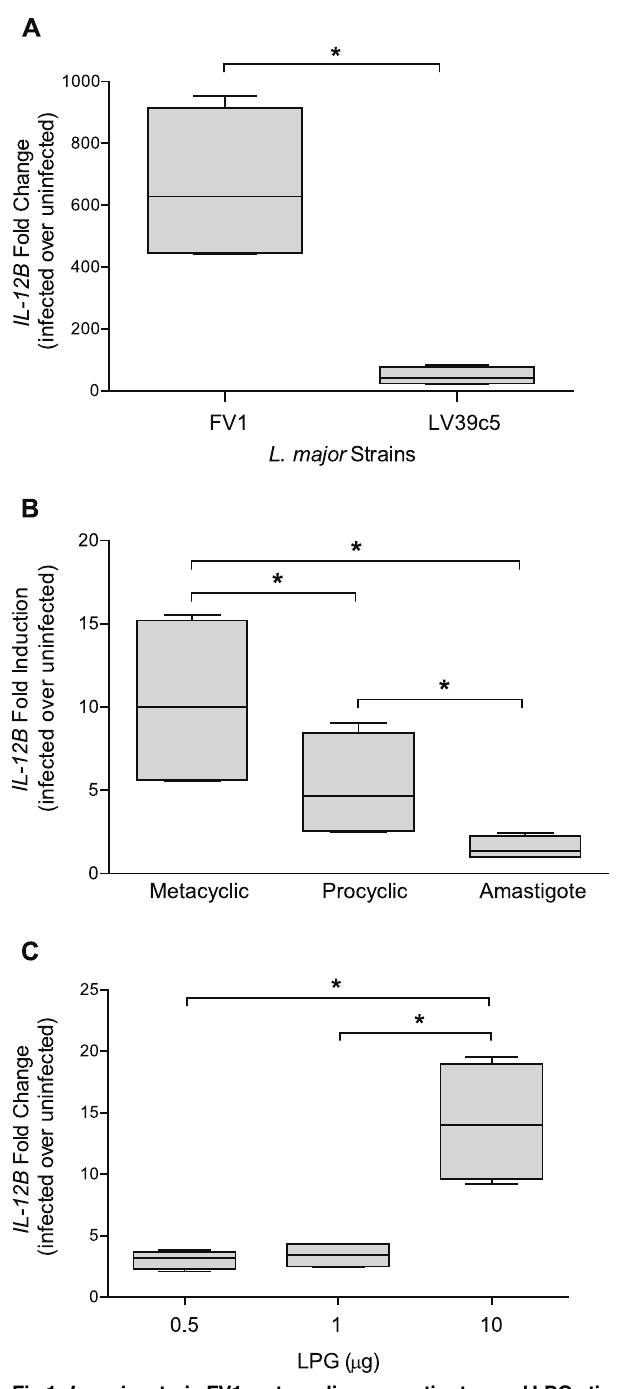
Fig 1. L . major strain FV1 metacyclic promastigotes and LPG stimulate IL12B expression. ( A ) Human DCs were infected with L . major FV1 or L . major LV39c5 parasite strains (n = 4 donors). After 8 hours, RNA was extracted from infected hDCs for cDNA generation and analyzed for IL12B expression by qRT-PCR. All values were significantly greater than uninfected. ( B ) Human DCs were infected with L . major FV1 metacyclic promastigotes (metacyclic), procyclic promastigotes (procyclic) or amastigotes (n = 3 donors). After 8 hours, RNA was extracted from infected hDCs for cDNA generation and analyzed for IL12B expression by qRT-PCR. All values were significantly greater than uninfected, except for amastigote infections. ( C ) Human DCs were exposed to different concentrations of LPG (0.5, 1, and 10 μ g), derived from L . major FV1 metacyclic promastigotes (n = 4 donors). After 8 hours, RNA was extracted from infected hDCs for